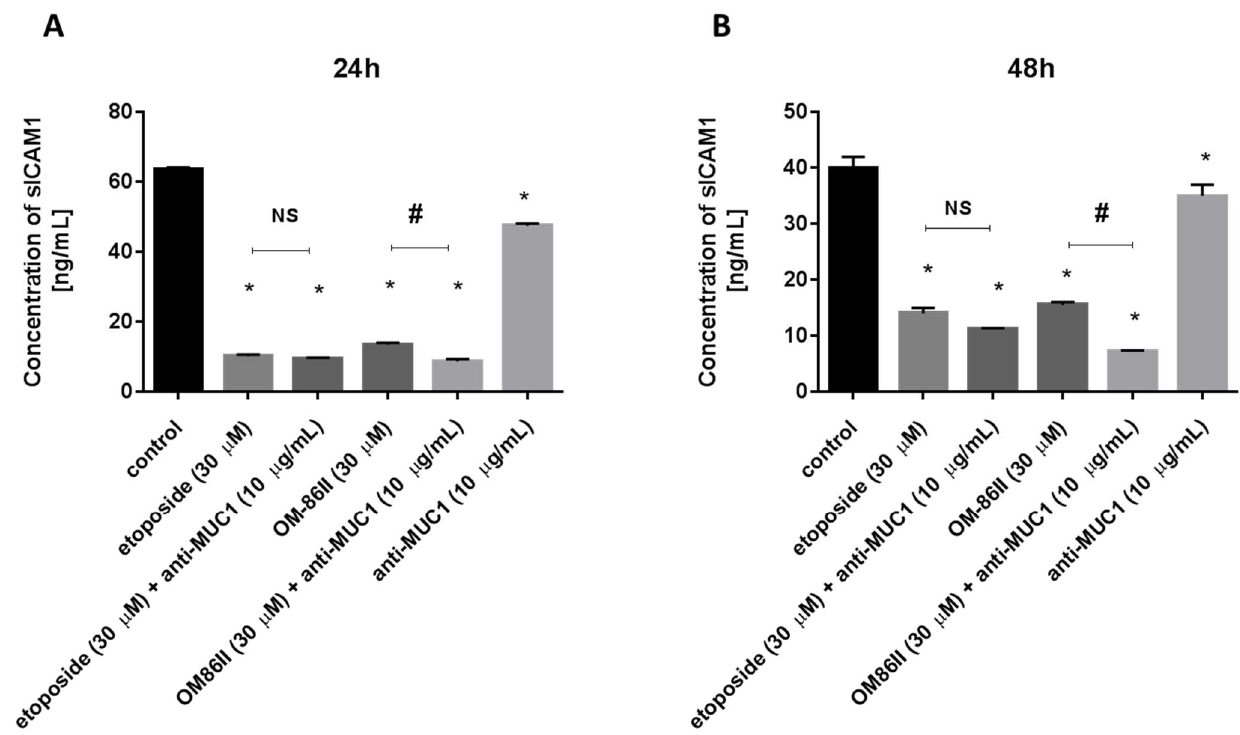
Figure 8. The concentration of sICAM1 in human gastric cancer AGS cells after 24 h ( A ) and 48 h ( B ) of incubation with anti-MUC1 (10 µg/mL), OM-86II (30 µM), OM-86II+anti-MUC1 (30 µM + 10 µg/mL), etoposide (30 µM) and etoposide + anti-MUC1 (30 µM + 10 µg/mL). Data are presented in ng/mL. * p < 0.05 vs. control group; # p < 0.05. MUC1, mucin-1; OM-86II, octahydropyrazin[2,1-a:5,4-a′]diisoquinoline derivative; ns, not significant.